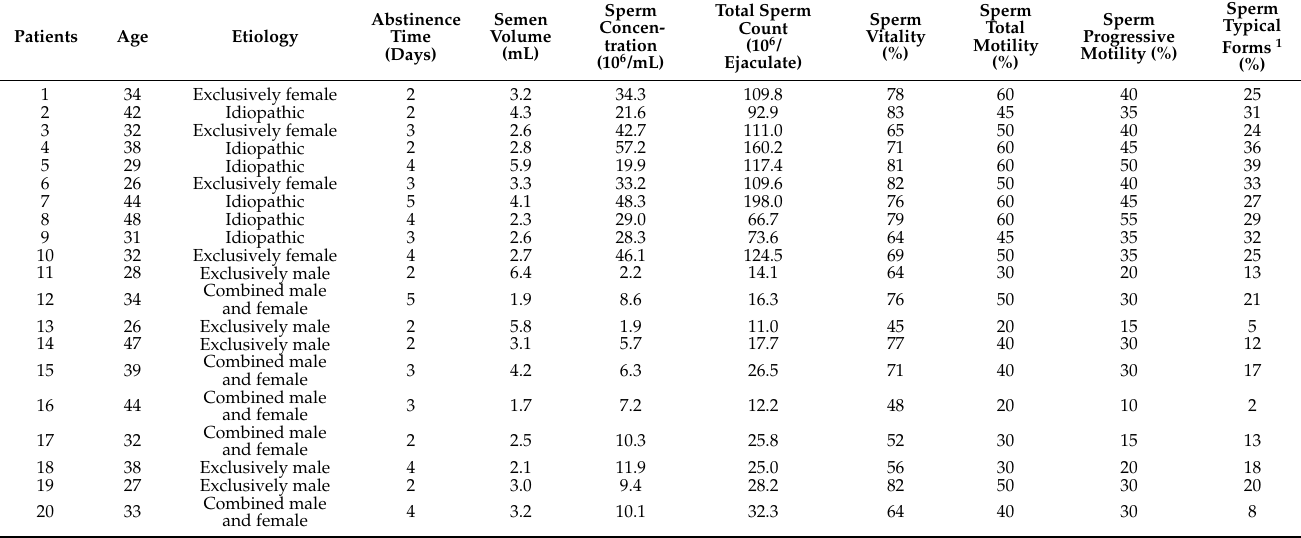
Table 1. Main sperm characteristics of the included